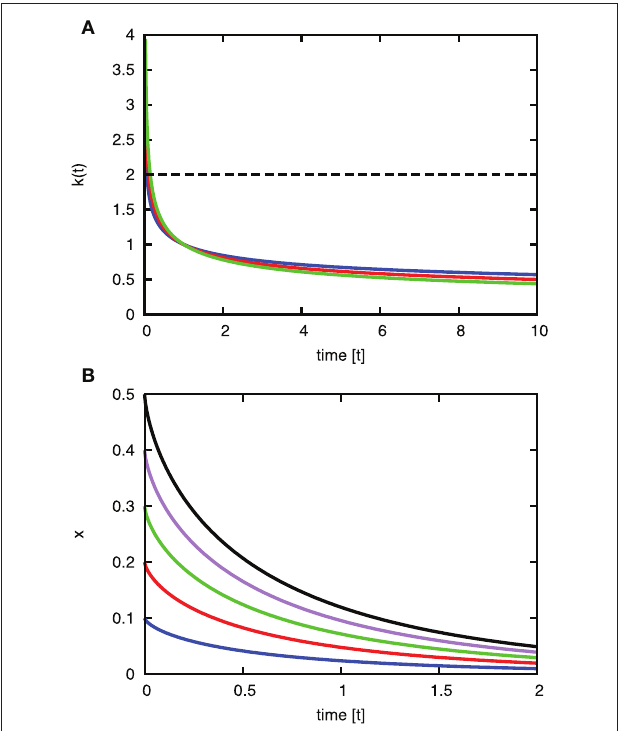
FiguRe 5 | Simulation Results in 3D space with non-reactive obstacles (NRO). (A) Fluctuation of k ( t ) with time. When less than 30% of 3D space is occupied by the NRO, k ( t ) behaves similarly to a constant (green line = 0%, FiguRe 4 | estimated characteristics of the value d (A) The curve of orange = 10%, magenta = 20%, brown = 30%). With NRO occupant close to s k ( t ) = t − 0.301 ± 0.056 . k ( t ) ( y axis) is plotted as a function of t ( x axis). Results are the percolation threshold, behavior of k ( t ) becomes similar to experimentally shown for minimum (blue), average (red), and the maximum (magenta) case of observed behavior. (B) Time course fluctuation of reactant concentration. the exponent of t among the range. Characteristics of the k ( t ) lines show that When the NRO occupancy is close to percolation threshold (blue = 65%, any constant k > 0 is smaller than k ( t ) at first but later exceeds this time- cyan = 60%), the fluctuation of the reactants shows a “quick response and dependent function. The dashed black line ( k = 2) is an example case. k (=2) is slow exhaustion” pattern. This result compares well with that presented in smaller than any k ( t ) line at the beginning of the reaction, and afterward it Figure 4B . (C) The behavior of mean-square displacement (MSD). At 0% NRO overcomes k ( t ). This means that the reaction governed by this function starts occupancy, MSD behaves as a normal diffusion. Between occupancies of rapidly in the inhomogeneous environment, but later slow down (relative to the 10% (red) and 40% (magenta), MSD exhibits hindered diffusion behavior. At classically assumed homogeneous environment). (B) Solution of the differential over 40% occupancy and up to the percolation threshold (60% = purple), the equation dx / dt = − k ( t ) x . The solution is xt The variation of the plot of MSD versus reaction time is concave, consistent with directed xt lines depends on the variation of a constant c from 0.1 to 0.5, which appears diffusion. Beyond the percolation threshold (70% = cyan), the curve becomes 1 in the right-hand term when we re-express the result as x t ce convex, indicating confined